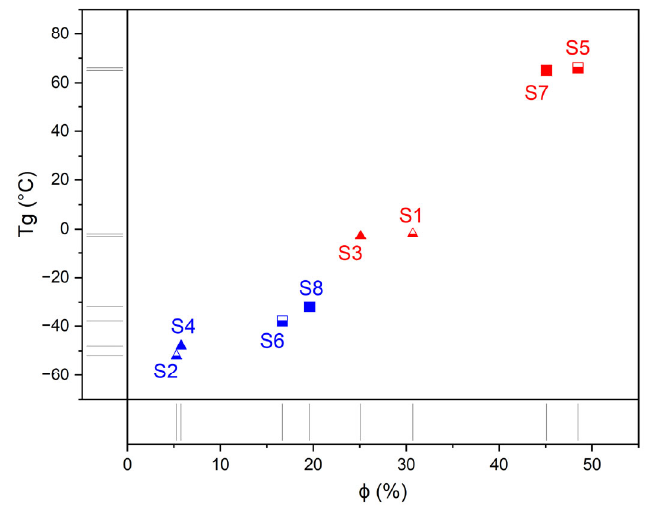
Figure 8. Correlation between the glass transition temperature ( T g , Table 2, @ 2 nd scans) in PUU S1–S8 and the fraction of bonded hard segments ( ϕ value, Table 1). PUU are based on PCL with a molecular mass of 530 (red) or 2000 g ∙ mol ⁻ ¹ (blue), on mPDA (triangles) or BAPS (squares), and on TDI (half solid) or MDI (solid).